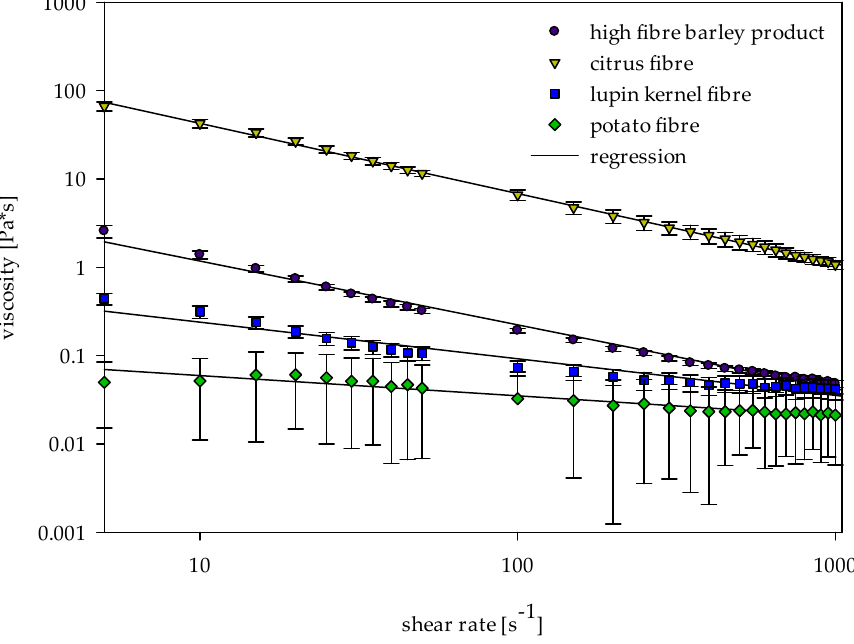
Figure 1. Viscosity of in vitro digested chymes containing different dietary fibre-rich materials as a function of the shear rate ( n = 3).